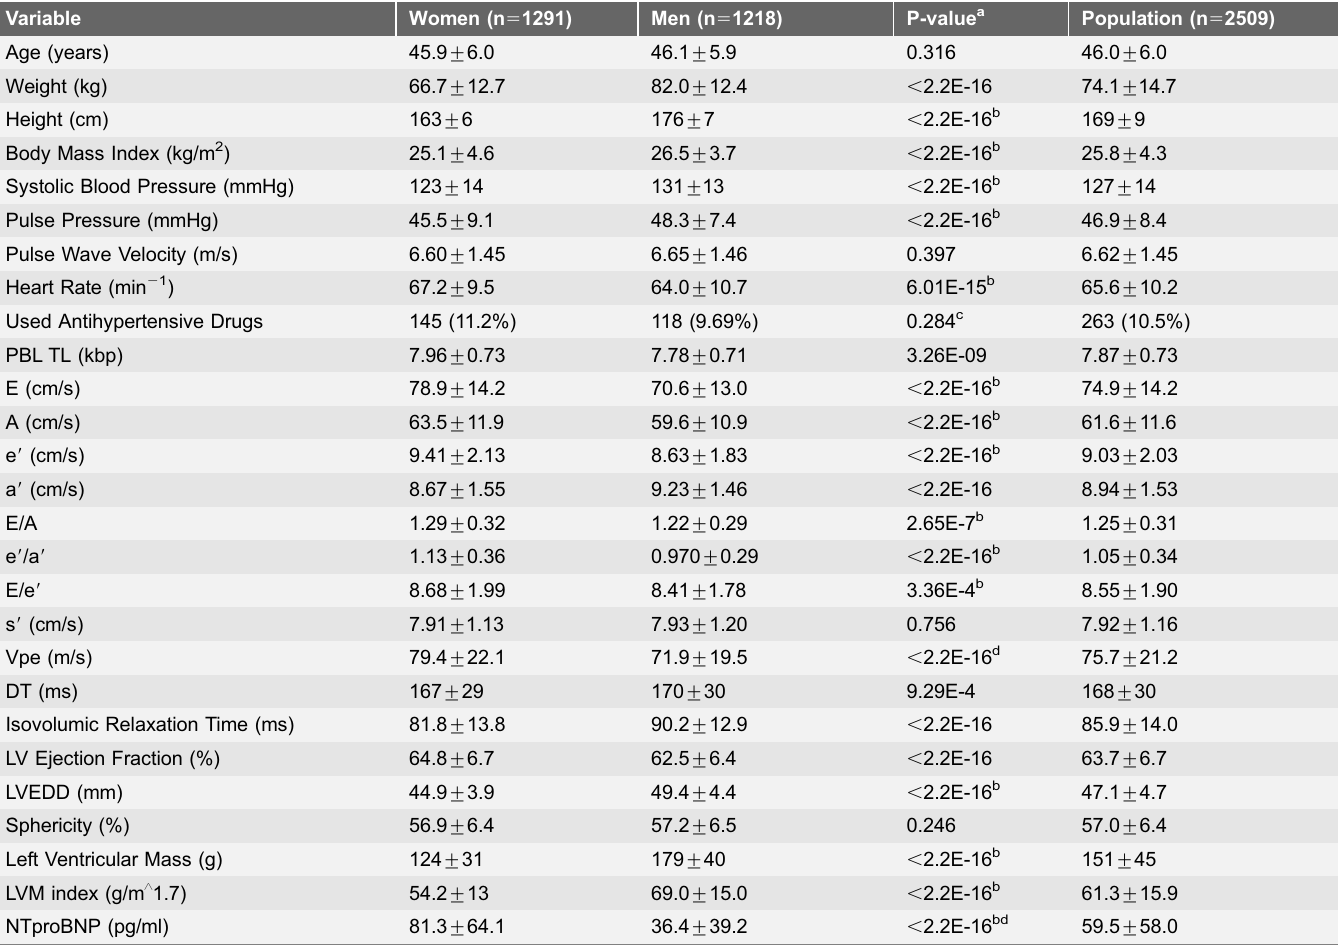
Table 1. Baseline characteristics of the Asklepios study